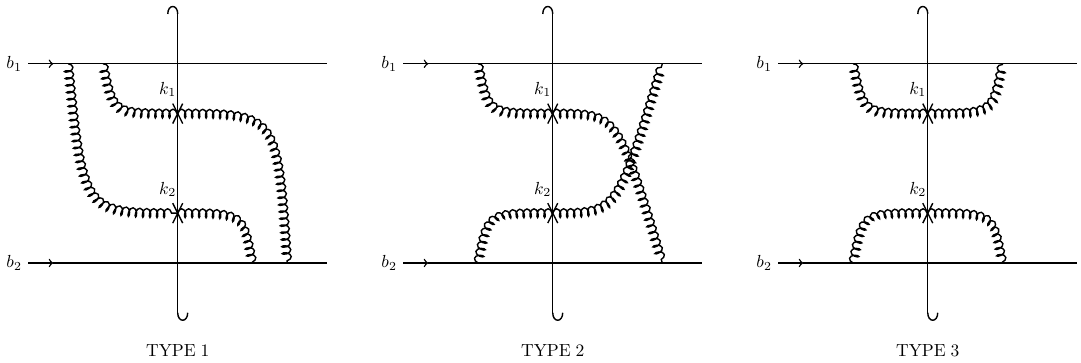
Figure 2 . Diagrams corresponding to the k T -factorized calculation of two-particle correlations. See the text for